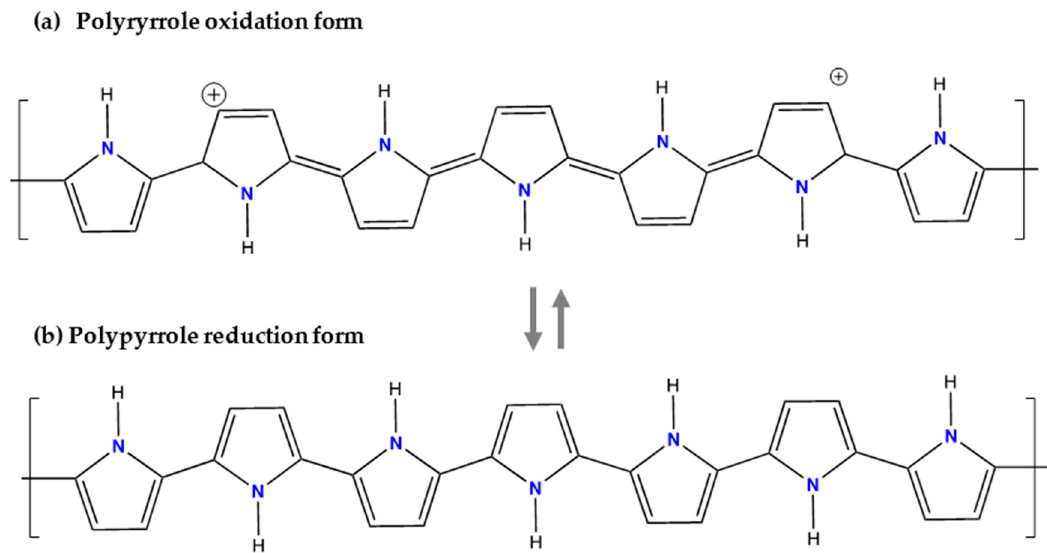
Figure 10. Structure of Polypyrrole for respective redox states. Illustration based from [65].